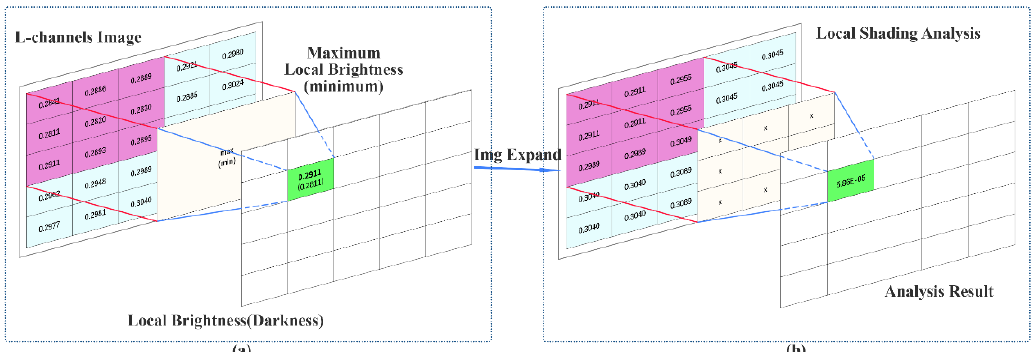
Figure 3. The shading partition enhancement consists of two parts: ( a ) used to obtain the maximum (minimum) pixel value in the local area of the input image and ( b ) the center pixel is enhanced by surrounding pixels.